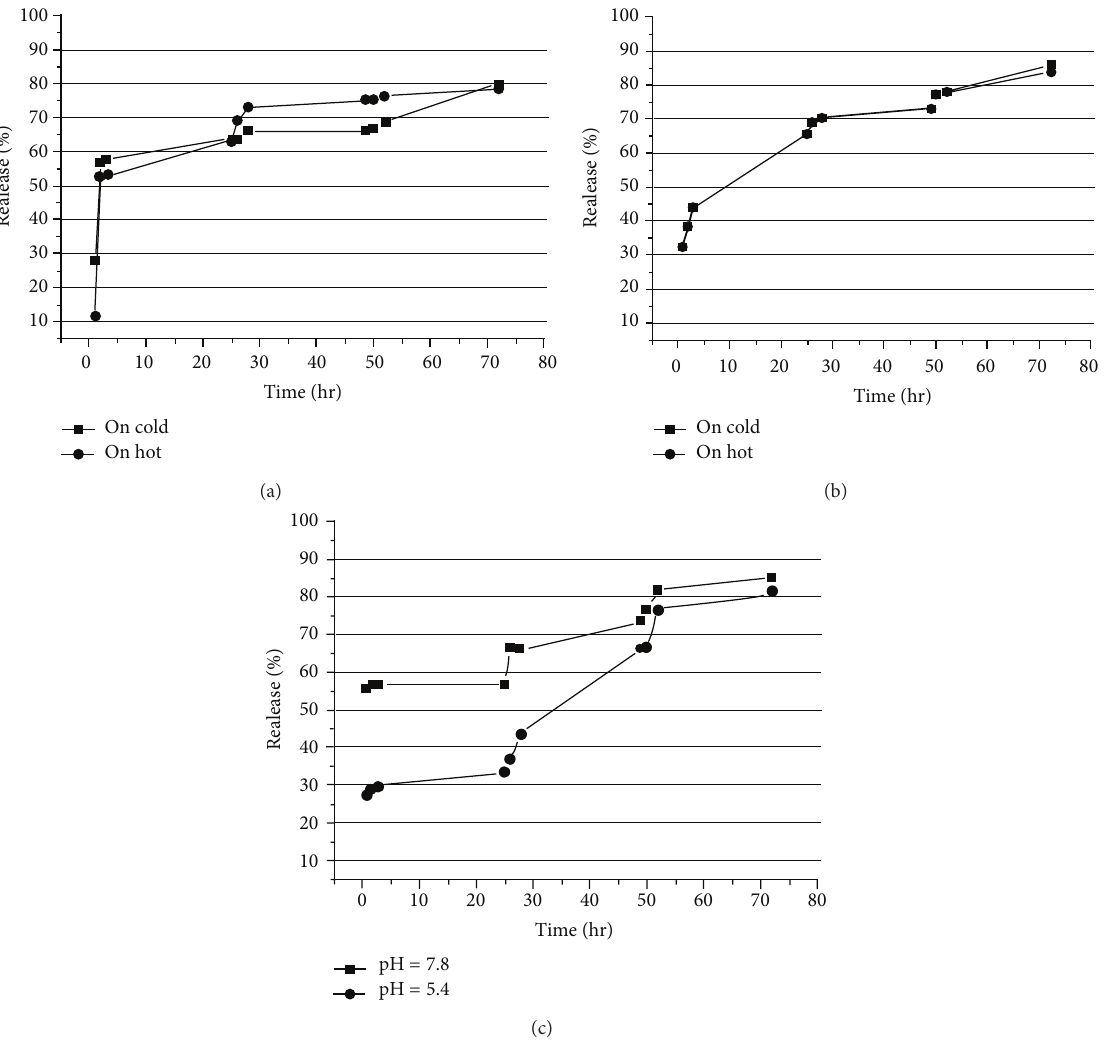
Figure 5: In vitro ibuprofen release in phosphate buffer solution at (a) pH = 7.8, and (b) pH = 5.4 at 37 ∘ C. ((a)-(b)) Mod-CS/MMT—ibuprofen (1:1) by different method. (c)